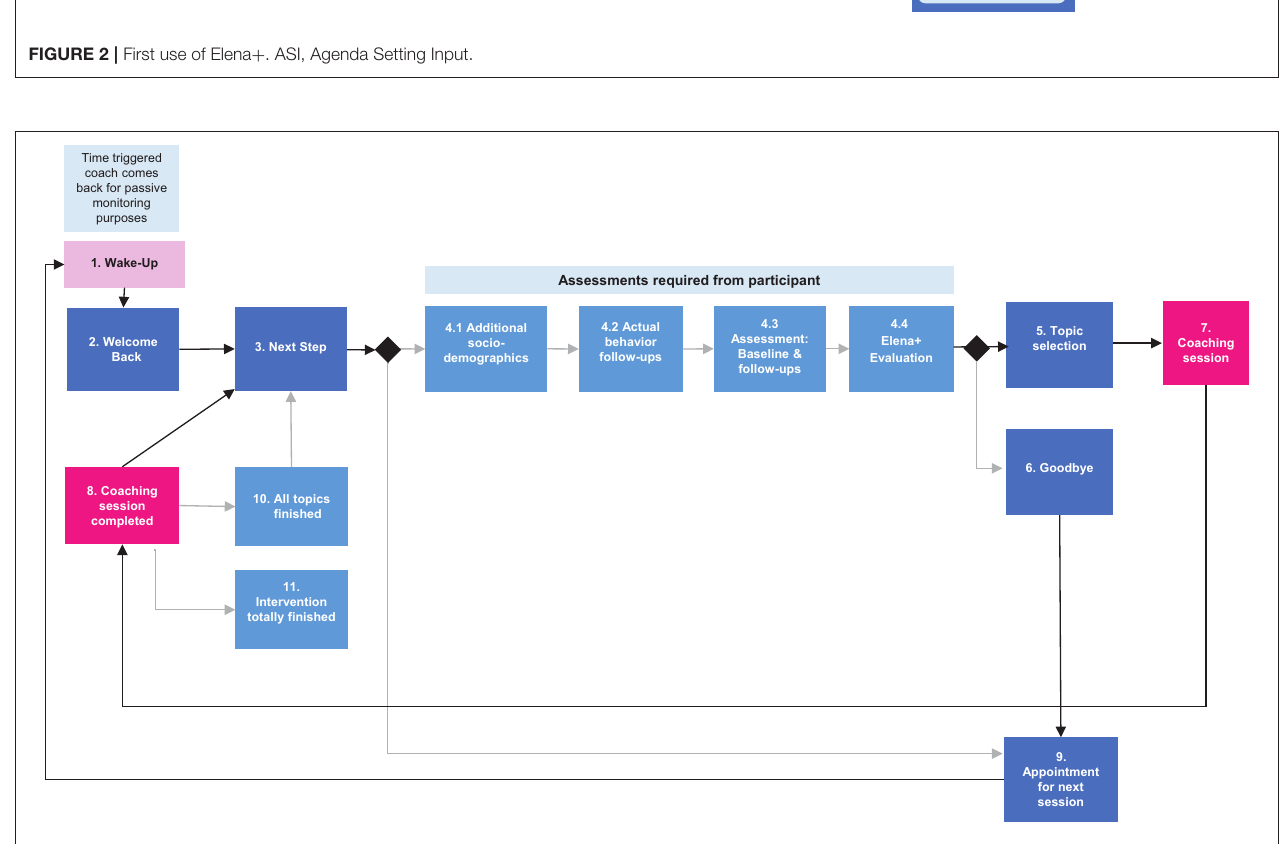
FIGURE 3 | Ongoing use of Elena +